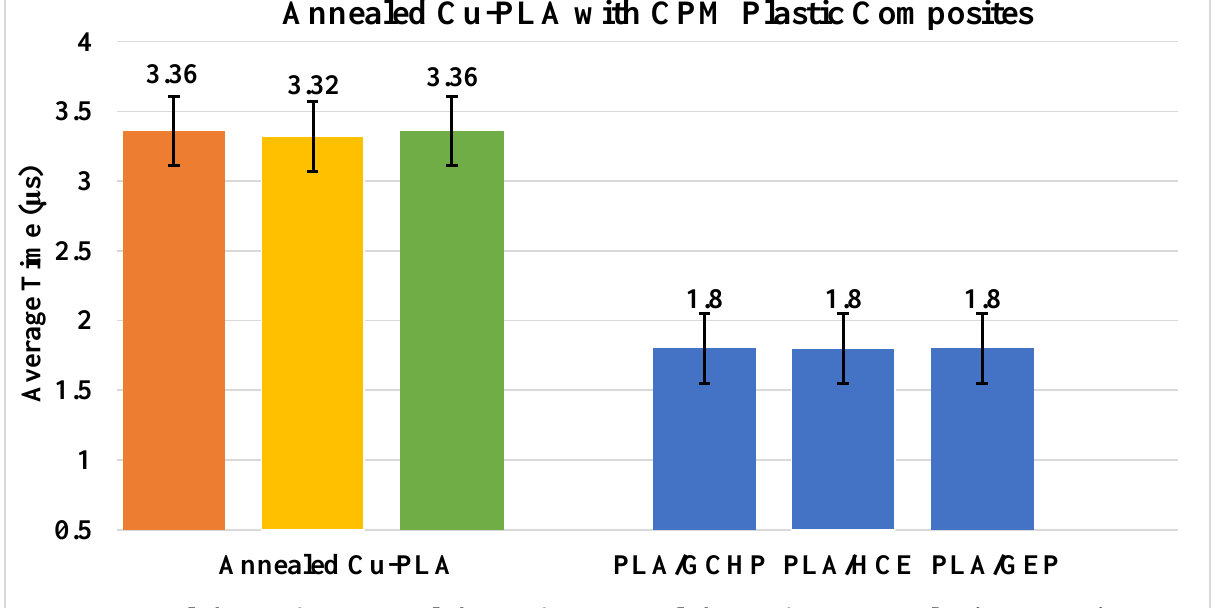
Figure 6. Results of annealed Cu-PLA with CPM plastic composites.